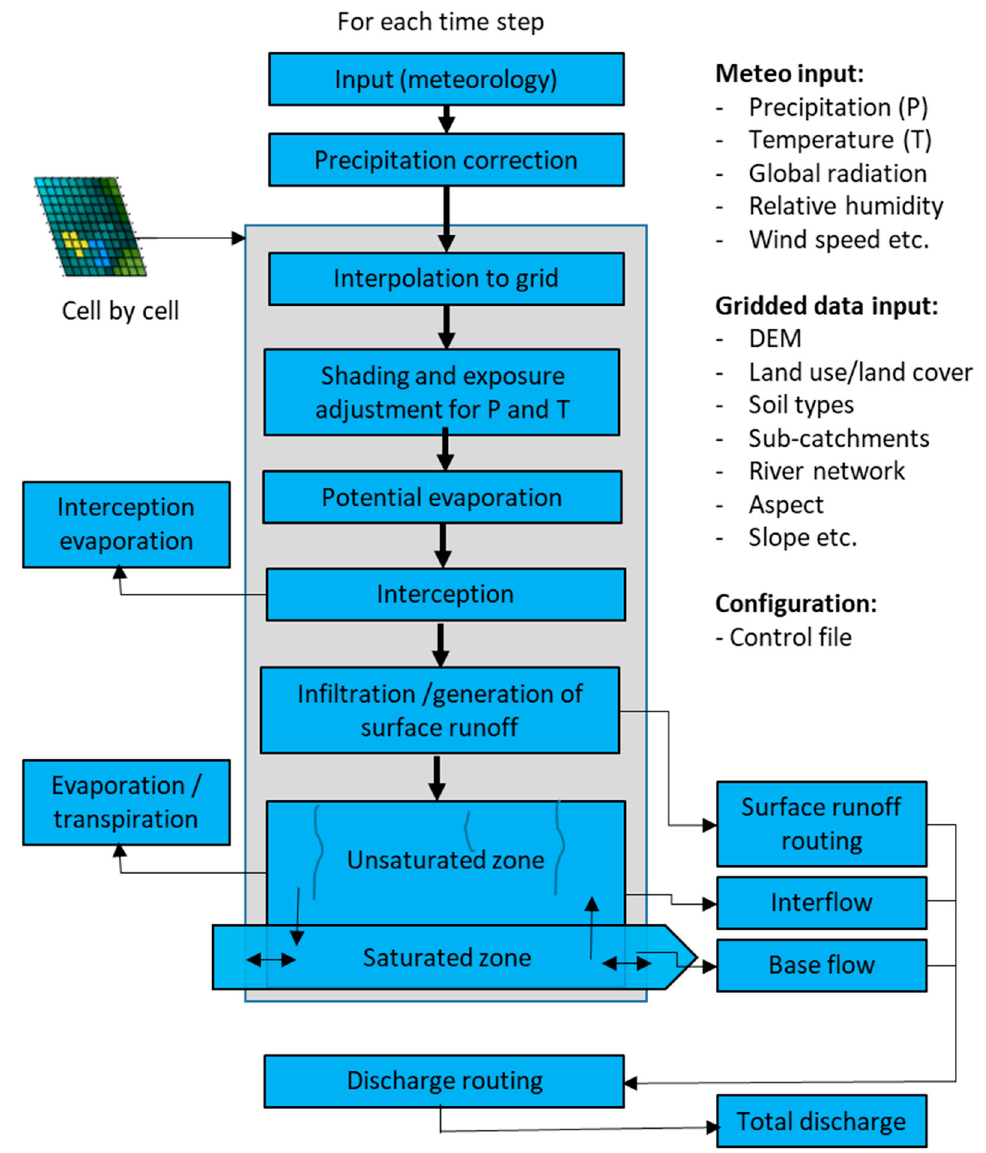
Figure 6 . Schematic representation of the water balance simulation model (WaSiM) with the implemented modules [46].